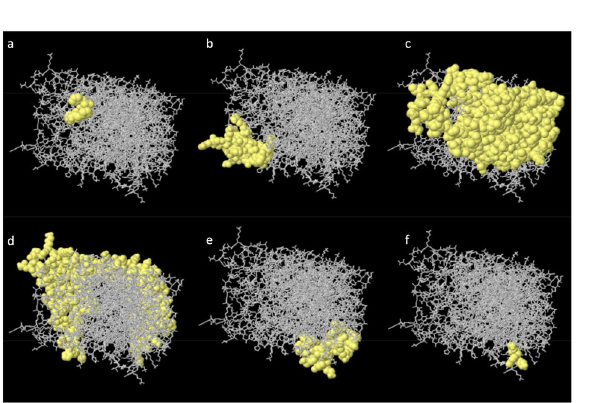
Figure 9. Vaccine 3D Structure Validation by ProSA-web. The Z-score of the refined model is -6.51 which is lying inside the score range. ProSA-web also plots the residues scores to check the local model quality and the negative values suggest no erroneous parts of the model structure.